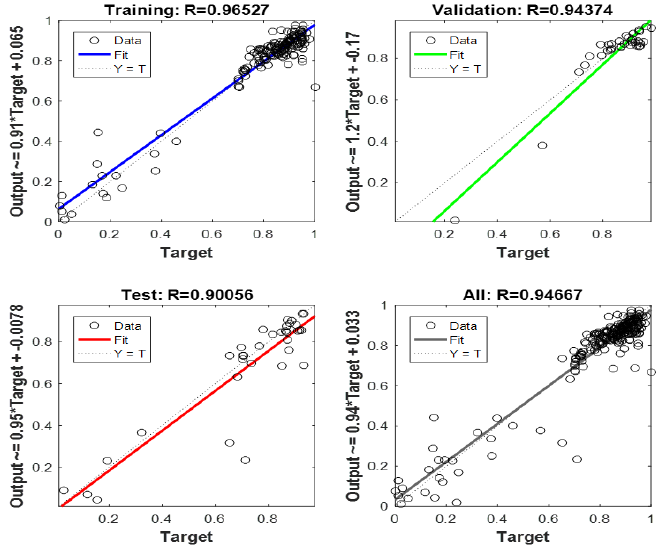
Figure 30. The correlation analysis